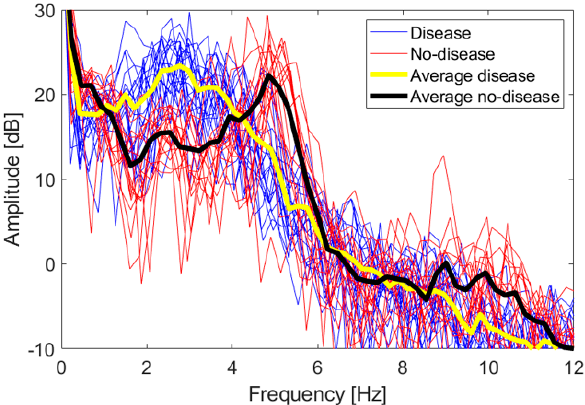
Figure 10. Frequency spectra of the z coordinate for both the disease and no-disease cases. The superposition of all spectra of each single FT take is shown, together with their average trend.